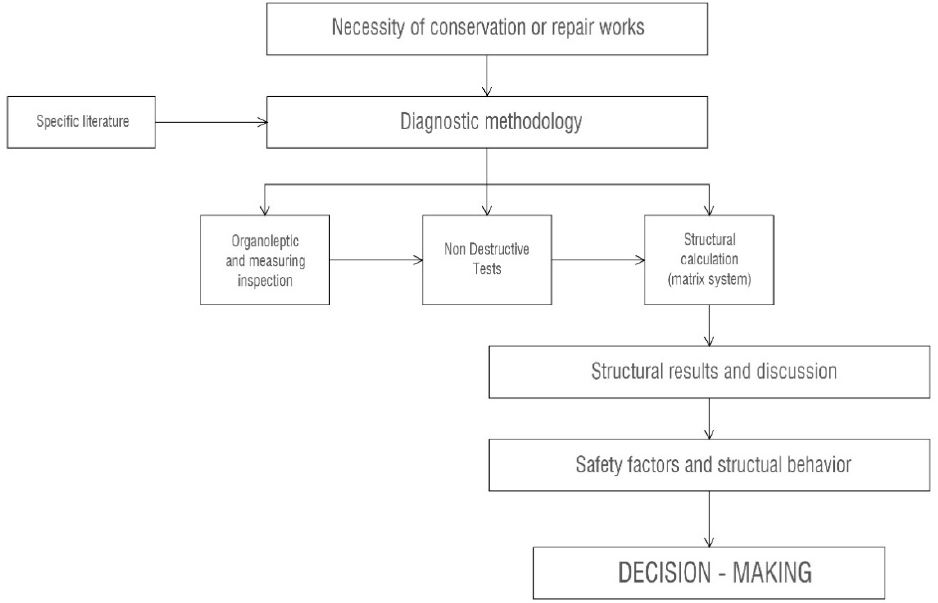
Figure 9. Workflow: steps of the proposed methodology.